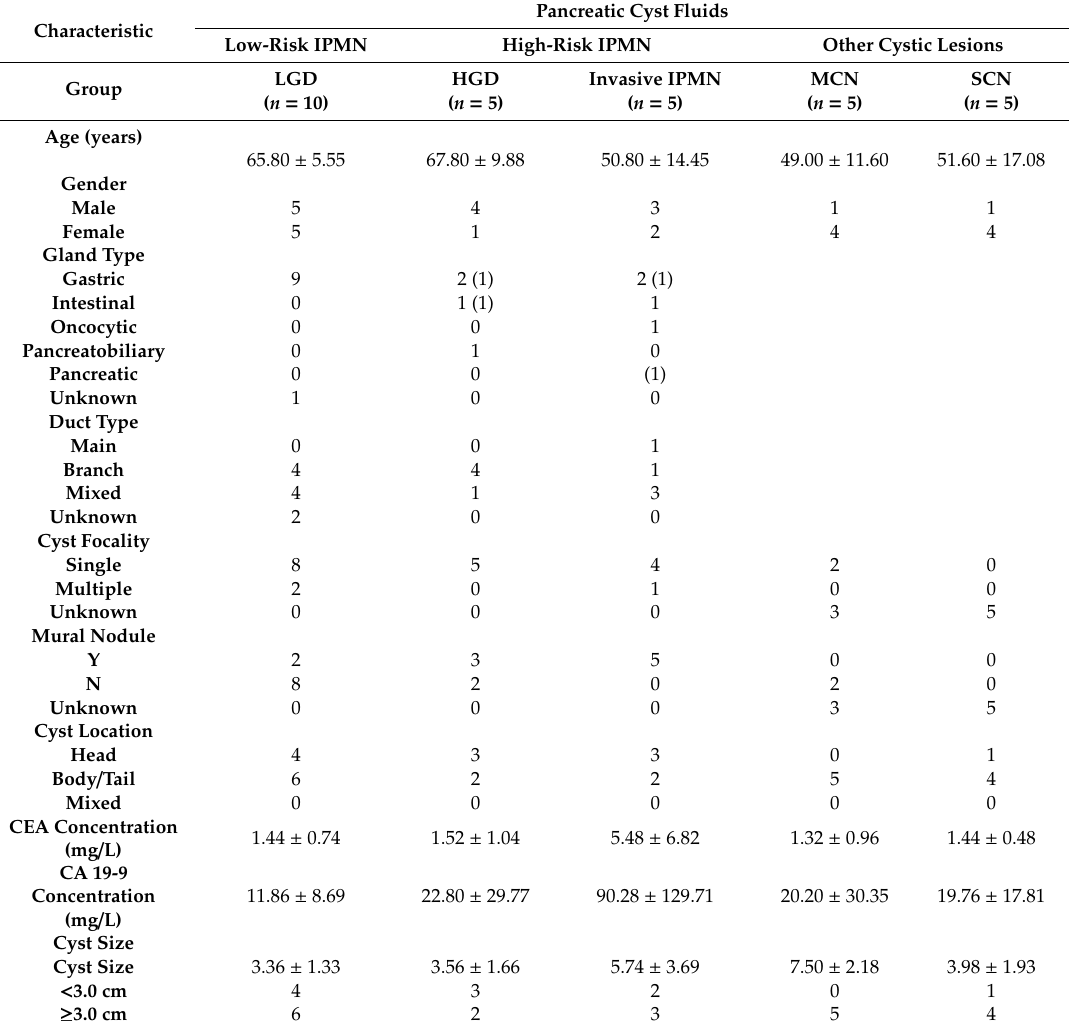
Table 1. Demographic and clinical characteristics of the study population in the label-free quantification.